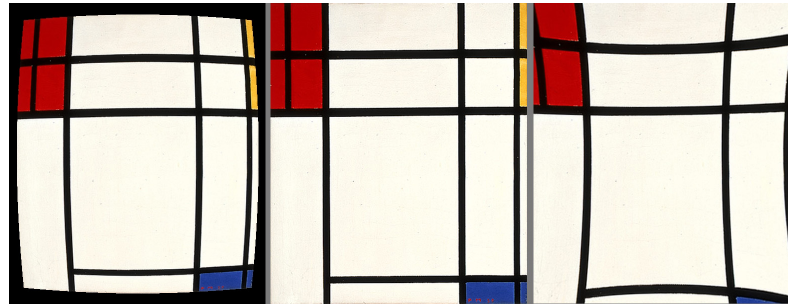
Figure 2. In the center, a painting from Piet Mondrian [12] (which is now in the public domain since 1 January 2016); on the left, the painting with a barrel effect; and on the right, the same image with pincushion